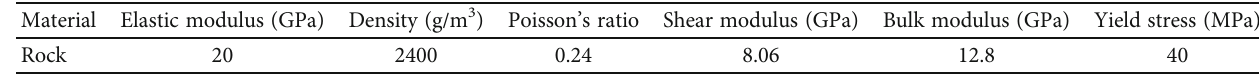
Table 2: Calculation parameters of rock